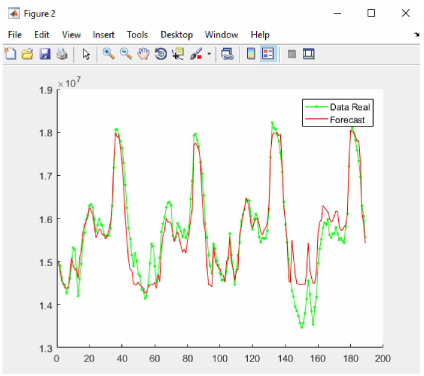
Fig. 18 Test result with traditional feed forward ANN for